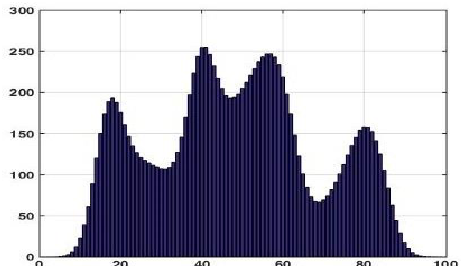
Figure 7. An IDS-vector, which has some hills (maxima) and dales